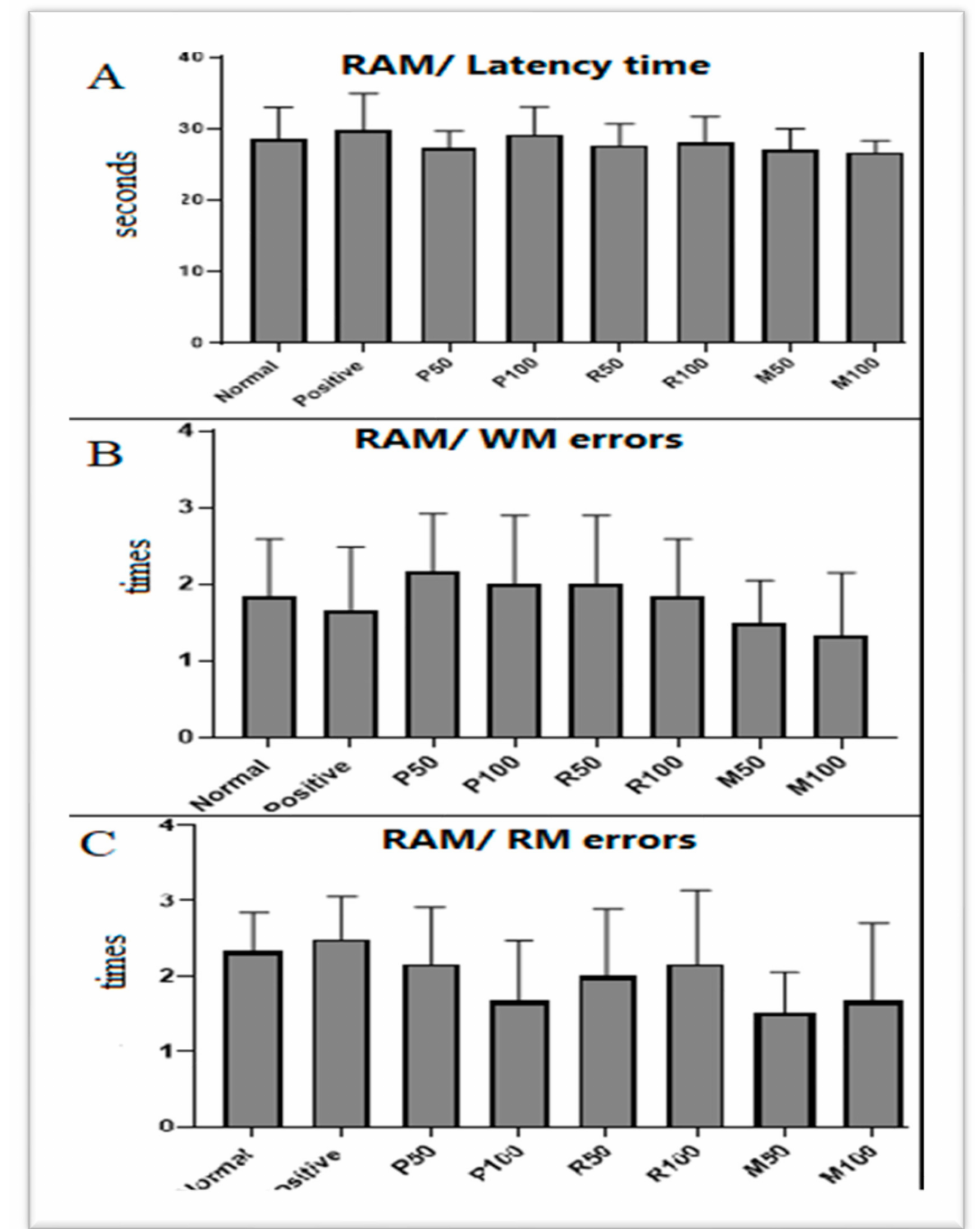
Figure 2. Nootropic radial maze test (RAM) results. ( A ) The latency time (seconds) to retrieve the hidden foods, ( B ) working memory (WM) errors, and ( C ) reference memory (RM) errors during eight visits that were all compared with the normal group. Values are presented as mean ± standard deviation (SD), n = 6 and statistical analysis was performed by one-way ANOVA followed by Tukey’s post-hoc test. N, Normal; +V, positive; P, peppermint oil extract; R, rosemary oil extract; PR, both peppermint oil extract and rosemary oil extract in which M50 means: 25 + 25 mg of both oil extracts, while M100 means 50 + 50 mg of both